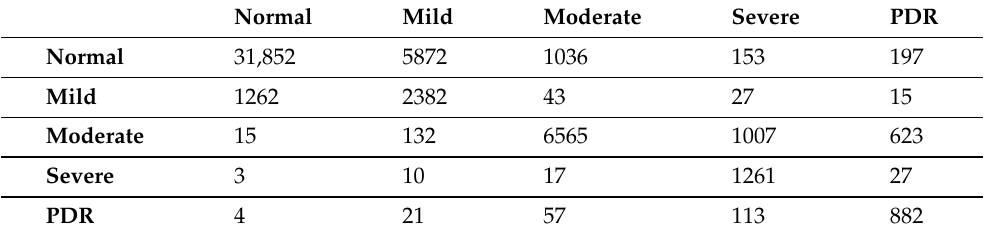
Table 11. Confusion matrix of LSTM-CNN, accuracy = 80.15%.